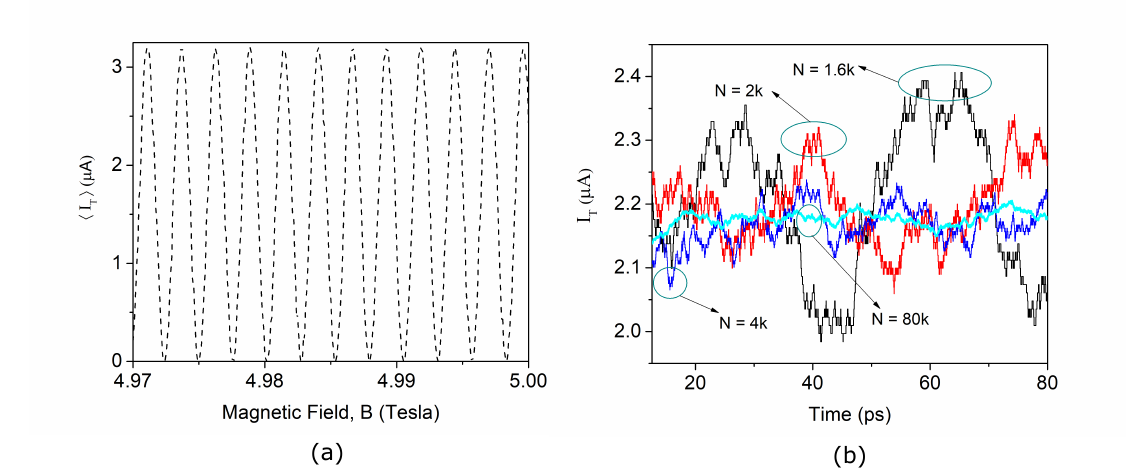
Figure 5. ( a ) The Aharonov-Bohm oscillations of the mean current resulting due to the interference of the wavepackets at the output of the Detector 2 oscillating between the maximum and minimum limit of the mean current. ( b ) The instantaneous current normalized to the number of particles is plotted at the output of the detector 2 of the MZI with respect to the simulation time, for different number of electrons N . As expected, the noise in the current reduces with the increase in the number of transport electrons due to the elimination of quantum uncertainty demonstrating the successful implementation of the protocol discussed in the